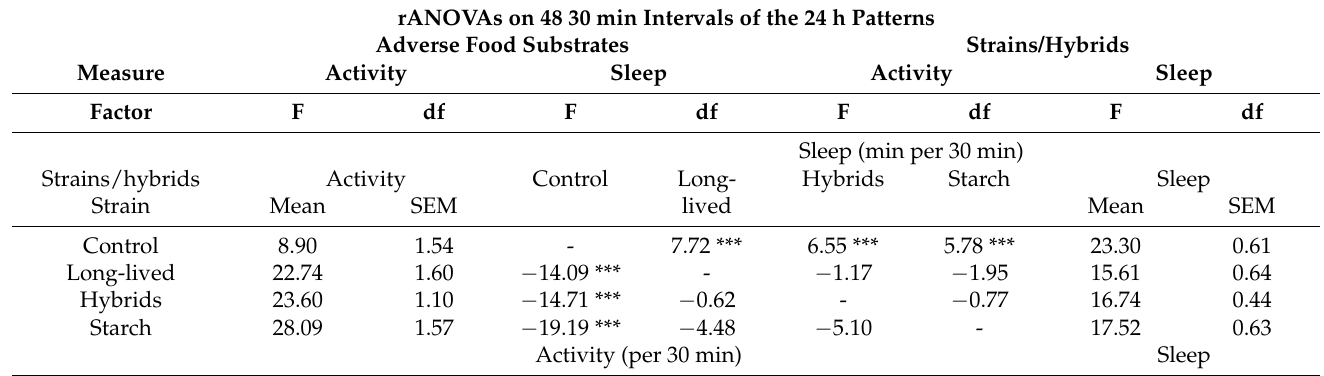
Table 2. Cont. rANOVAs on 48 30 min Intervals of the 24 h Patterns Adverse Food